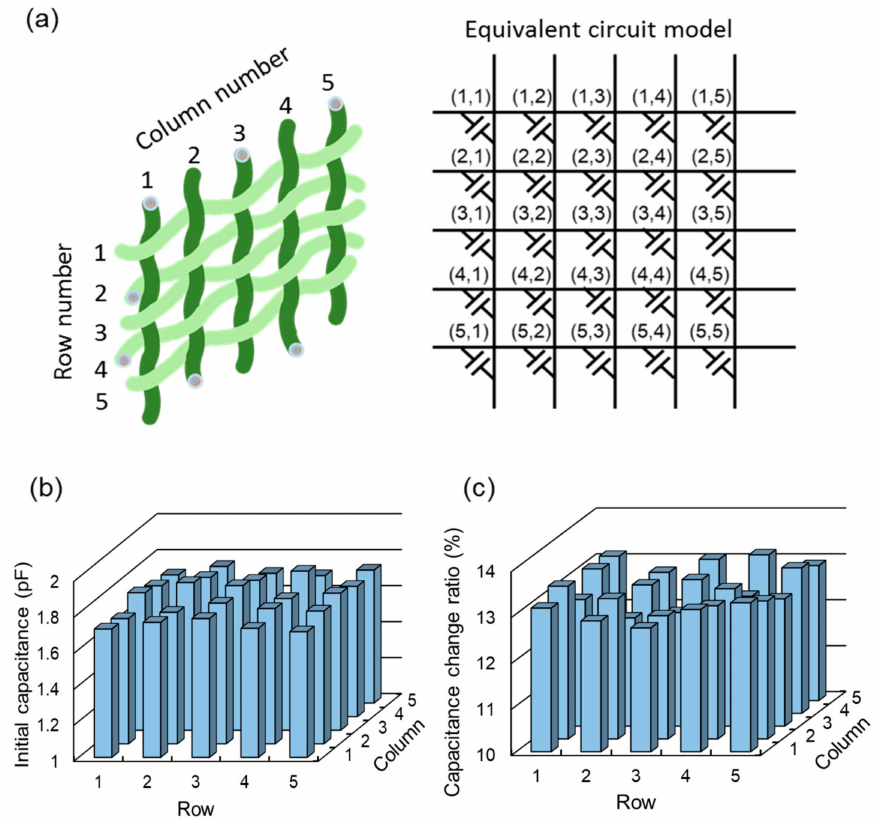
Figure 8. ( a ) Equivalent circuit model of the device in capacitive tactile sensor mode. ( b ) Initial capacitances of sensor composed of 25 capacitive cells. ( c ) Capacitance change ratio after applying vertical force of 2 N.